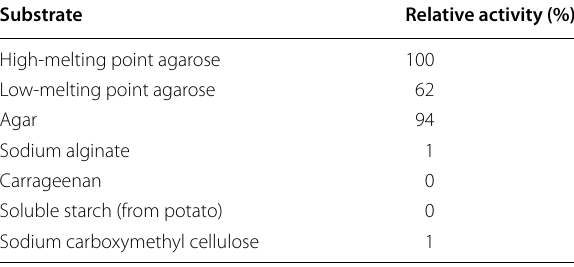
Table 2 Substrate specificity of